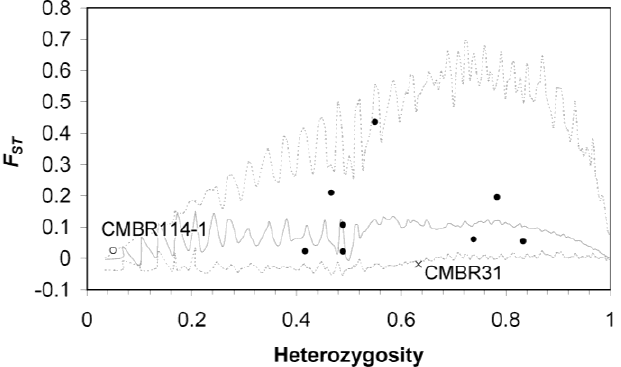
Figure 2. Distribution of population genetic differentiation index F heterozygosity by simulation, while considering the neutral markers only, and forcing the mean F under a stepwise mutation model. The dashed lines and the solid line represent ST the 0.95 quantiles and the median, respectively. Each dot represents a microsatellite locus; loci above the 0.95 quantile line (upper dotted line) were classified as under divergent selection, while those below the lower dotted line were classified as loci under balancing selection.